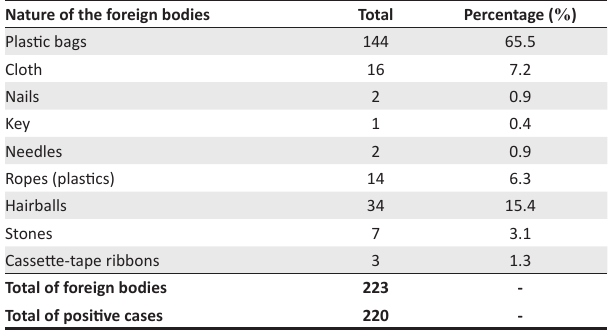
TABLE 5: Occurrence of foreign bodies according to their nature (type). Nature of the foreign bodies